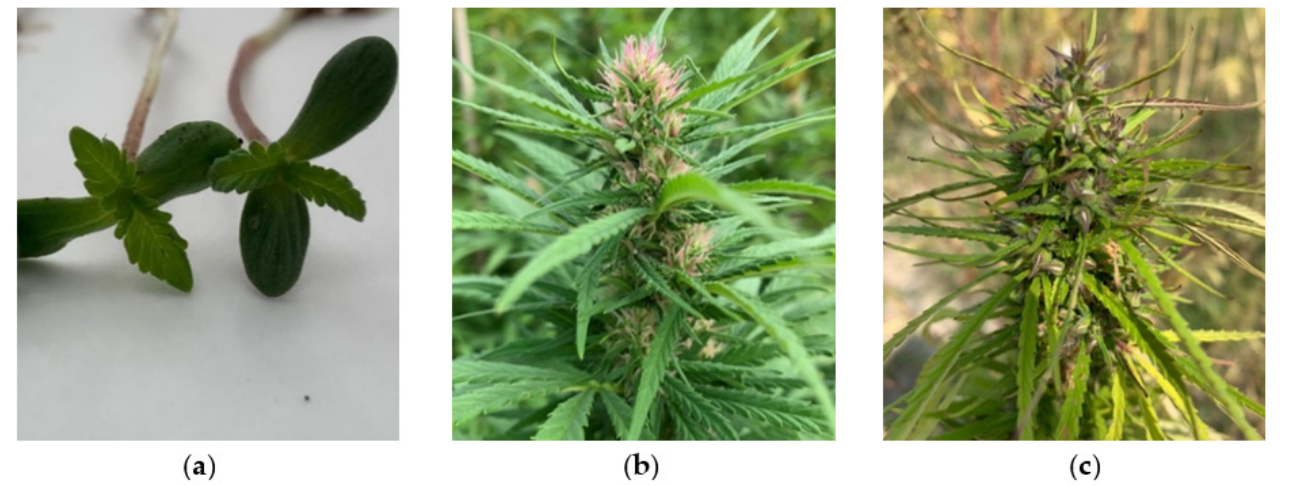
Figure 3. ( a ) Cannabis samples collected for DNA extraction, molecular cloning and sequencing. ( b ) CINRO female inflorescence 50 days after onset flowering. ( c ) Chemotype III dioecious genotype female inflorescence 151 days from sowing.